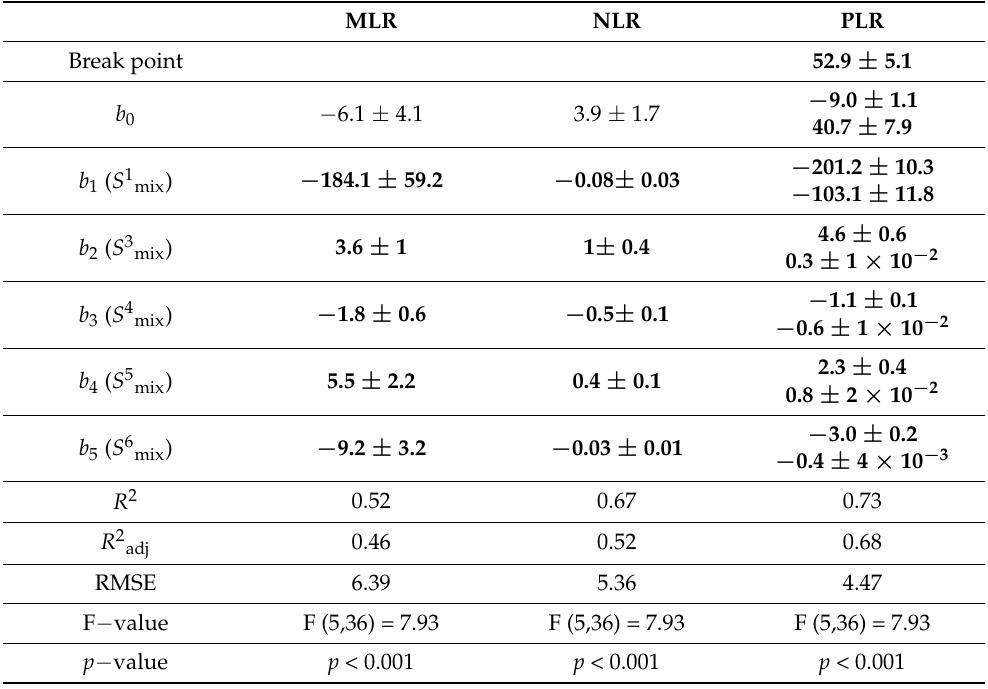
Table 4. MLR, NLR and PLR coefficients for prediction of extraction efficiencies based on DESs S i mix descriptors (significant coefficients for p < 0.05 are marked